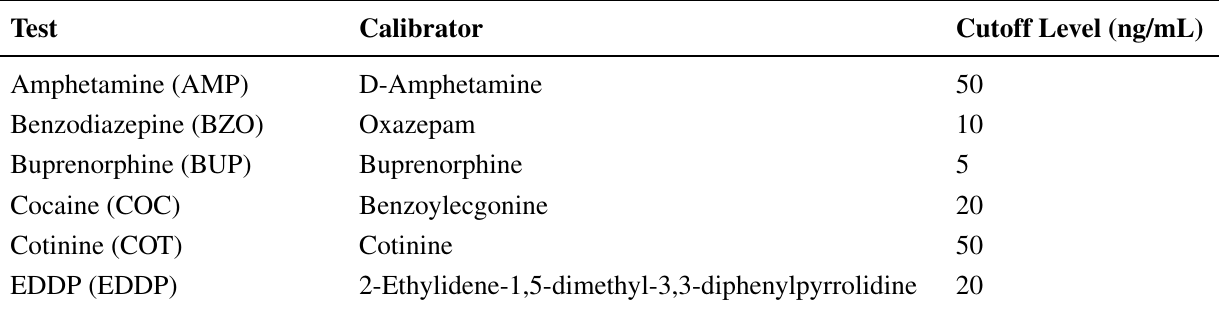
Table 1. Calibrators and cutoff levels for different line-based drug